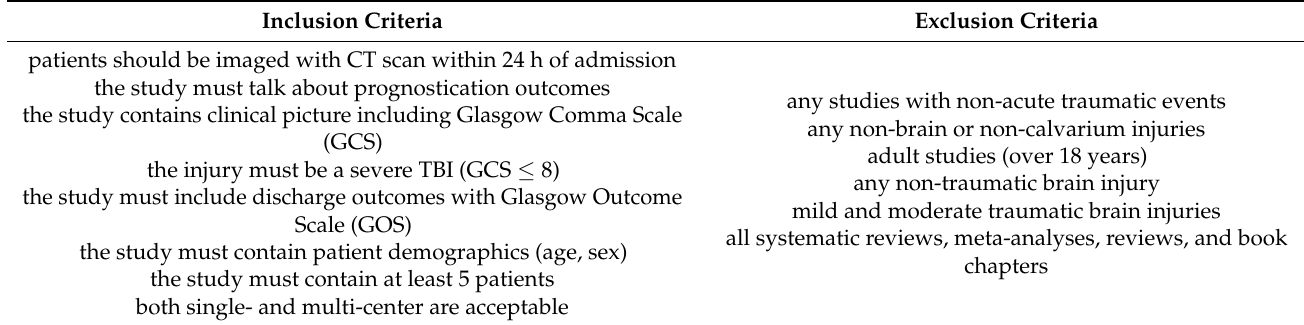
Table 1. Inclusion and exclusion